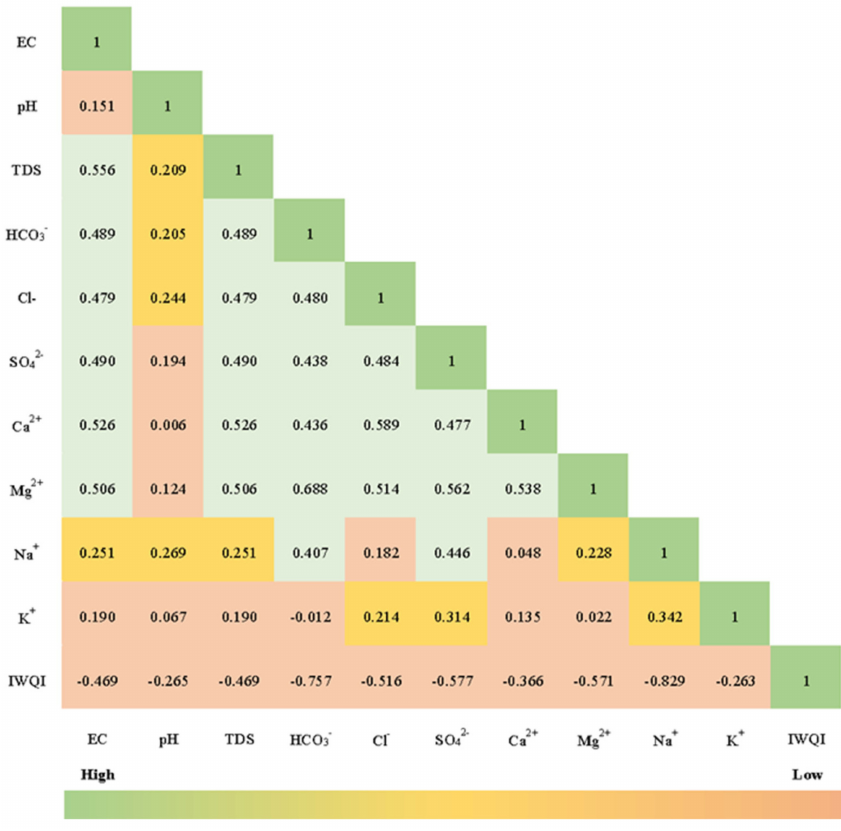
Figure 22. Correlation matrix of hydrochemical